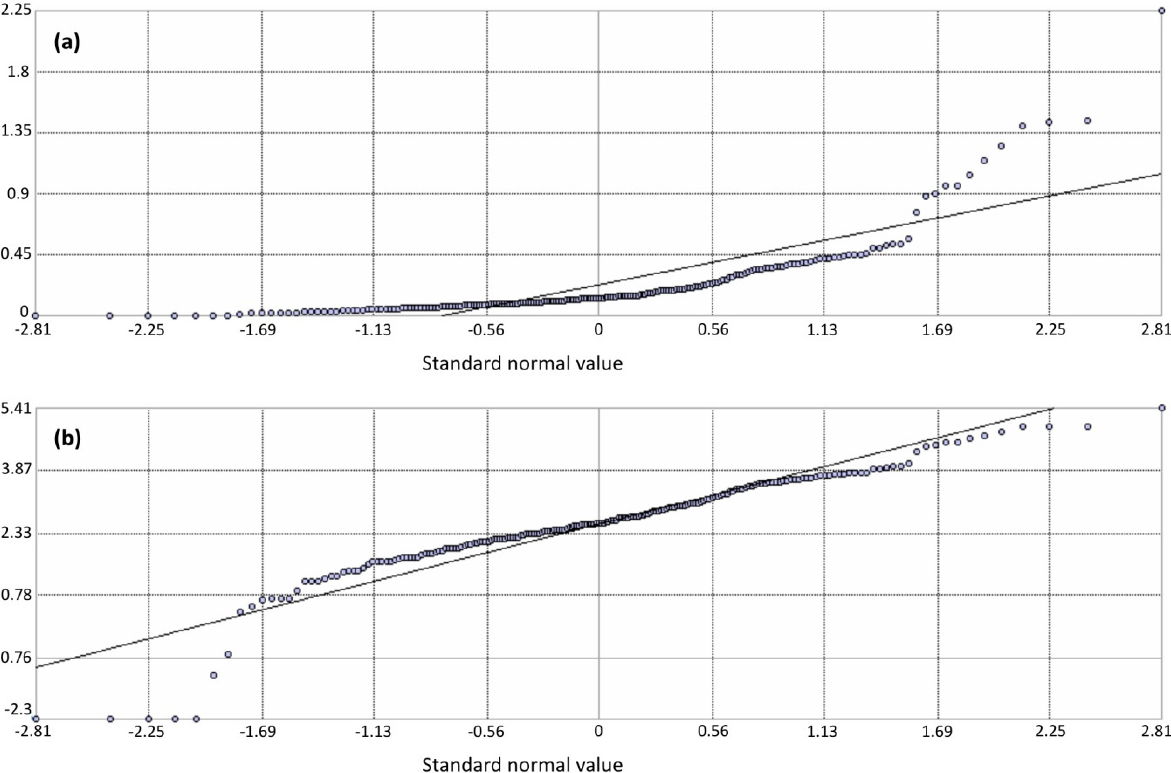
Figure 7. QQ-Plot of the ( a ) original data and ( b ) log-transformed data of the basal aquifer. The settings that gave the lower prediction error and cross-validation results are shown in Table 2 and the resulting maps are shown in Figure